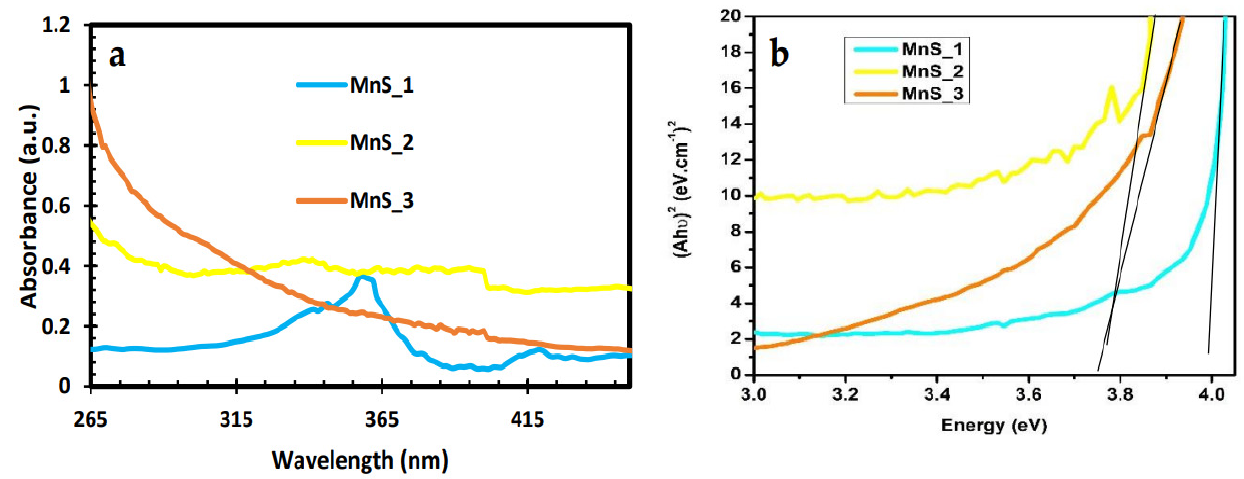
Figure 4. UV-Vis spectra ( a ) and Tauc plot with extrapolated linear line ( b ) of MnS_1, MnS_2 and MnS_3 nanoparticles. 2.5. PL